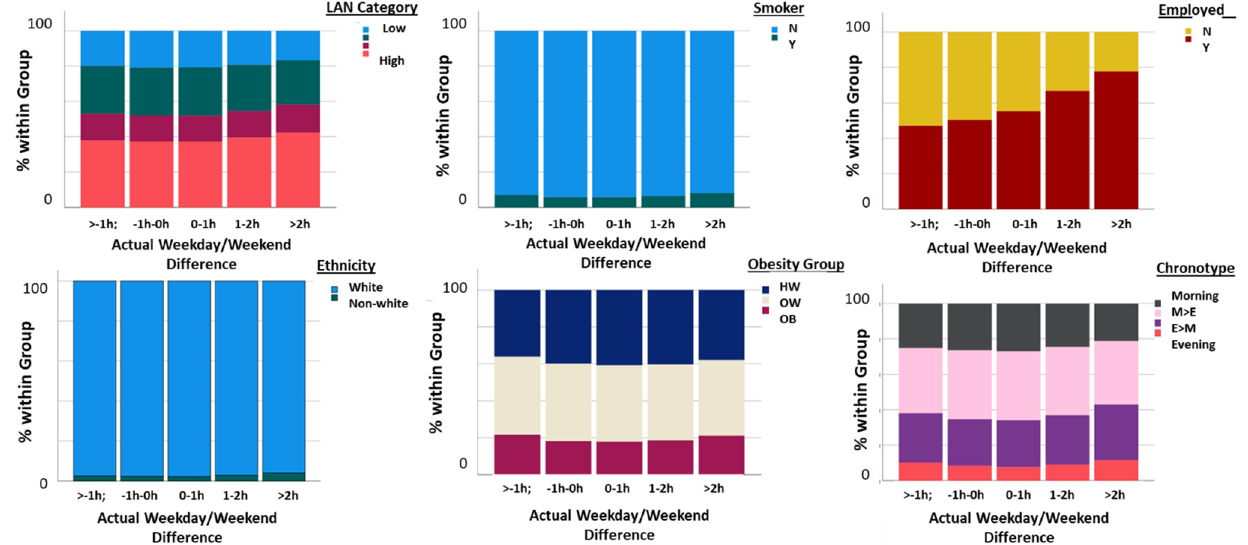
Figure 6. Bar graphs showing the associations between actual WD/WE sleep offset differences, expressed as a categorical variable with five levels (> − 1 h, − 1 h to 0 h, 0 h to 1 h, 1 h to 2 h, >2 h) with LAN categories (expressed as quartiles, low to high), smoking status (note the overall low level of smoking in the sample), employment status, ethnicity expressed as white/non-white (note the small percentage of non-white participants in the sample overall), obesity group (HW = healthy weight, OW = overweight, OB = obese) and chronotype as categorized as morning types, more morning than evening type (M > E), more evening than morning types (E > M) and evening types.